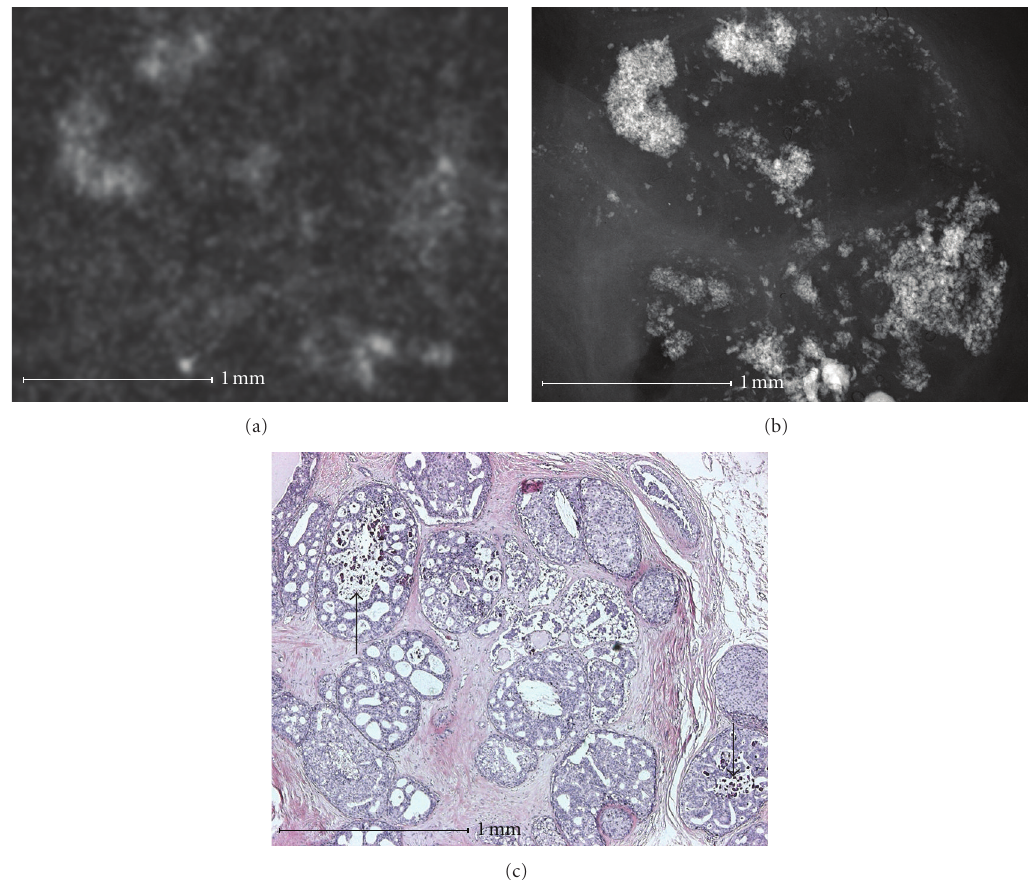
Figure 1: Cribriform intraductal carcinoma in situ (nonhigh grade). Microcalcifications (b) that are amorphous and indistinct in microradiography and in conventional specimen radiography (a). Histological evidence of gravel-like calcifications (arrow in (c)). In the histological as well as the microradiographic image, the calcifications have not yet condensed to form larger structures compared to Figure